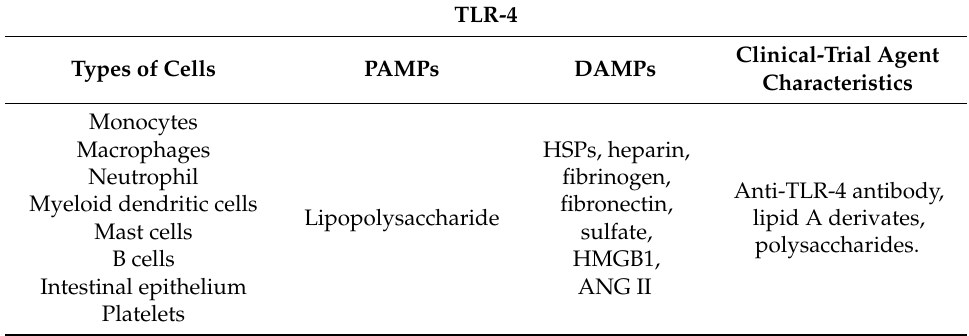
Table 2. Characteristics of TLR-4 receptor: types of cells expressing TLR-4, pathogen-associated molecular patterns (PAMPs), danger-associated molecular patterns (DAMPs), and clinical-trial